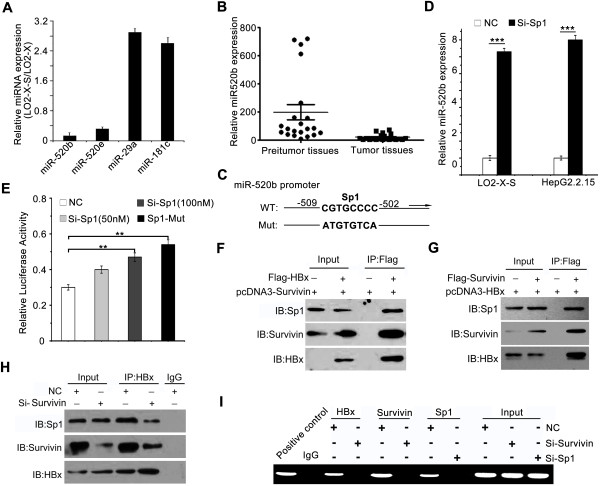
HBx down-regulates miR-520b through binding to Sp1 with partner survivin. (A) The expression levels of miRNA-520b, miRNA-520e, miRNA-29a and miRNA-181c were examined by qRT-PCR in LO2-X-S/LO2-X cells. (B) The expression of miR-520b in clinical HCC and peritumor samples was detected by qRT-PCR. (C) A model shows Sp1 binding site-directed mutation in the promoter region of miR-520b. (D) The effect of knockdown of Sp1 on miR-520b in LO2-X-S or HepG2.2.15 cells was examined by qRT-PCR analysis (***P < 0.001, Student’s t test). (E) The effect of Sp1 on miR-520b promoter in LO2-X-S cells was tested using Sp1 siRNA (Si-Sp1) or Sp1 mutant by luciferase reporter gene assays (**P < 0.01, Student’s t test). (F-H) The interaction among HBx, survivin and Sp1 in a complex was examined by co-IP. (I) Interaction of the complex, including HBx, survivin and Sp1, with the promoter region of miR-520b was examined by ChIP in LO2-X-S cells.